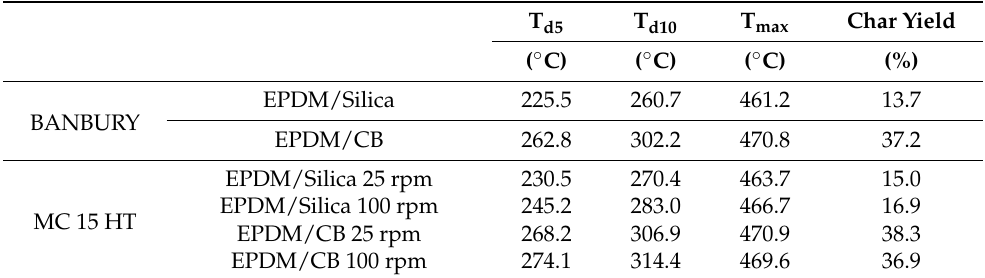
Table 5. TGA results of the